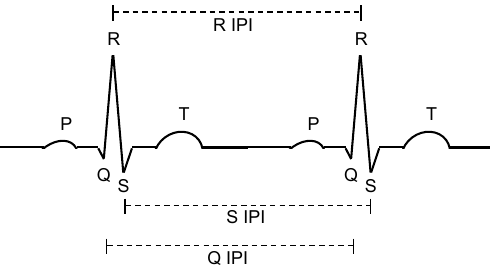
Figure 2. Characteristics of the heart signal and Inter-Pulse-Intervals (IPI) between